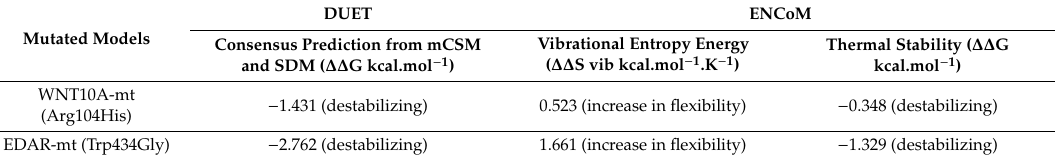
Table 2. Estimated protein structure quantitative stability changes upon